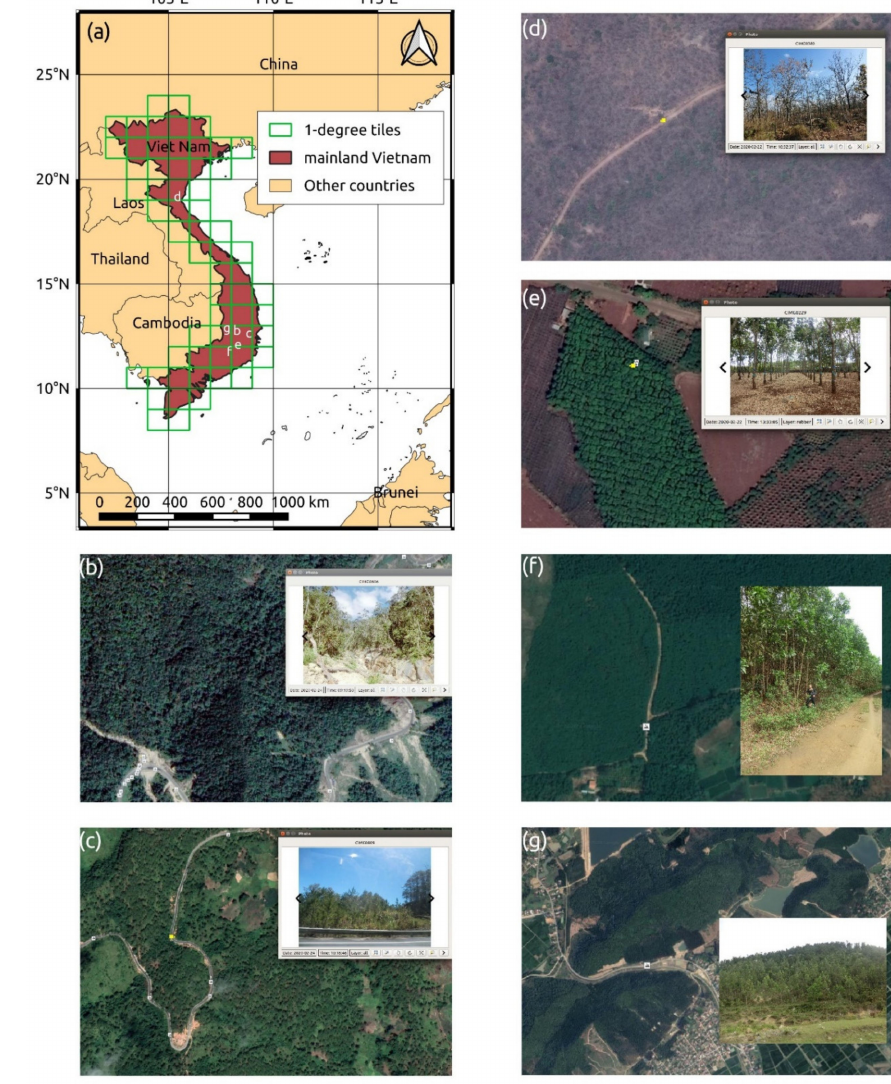
Figure 1. Study area and forest types in mainland Vietnam through ground-truth photos and high-resolution Google Earth (GE) images. ( a ) Location of mainland Vietnam; ( b ) natural evergreen broadleaf forest at 12.2209 ◦ N, 108.7455 ◦ E with a field photo (24 / 02 / 2020) and GE image (09 / 03 / 2019); ( c ) natural coniferous forest at 12.1338 ◦ N, 108.6196 ◦ E with a field photo (24 / 02 / 2020) and GE image (19 / 01 / 2020); ( d ) natural deciduous forest at 12.8436 ◦ N, 107.7780 ◦ E with a field photo (22 / 02 / 2020) and GE image (01 / 03 / 2020); ( e ) rubber plantation at 12.6557 ◦ N, 107.8437 ◦ E with a field photo (22 / 02 / 2020) and GE image (01 / 03 / 2019); ( f ) acacia plantation at 12.7768 ◦ N, 108.8242 ◦ E with a field photo (23 / 02 / 2020) and GE image (09 / 03 / 2020); ( g ) eucalyptus plantation at 19.1783 ◦ N, 105.5992 ◦ E with a field photo (23 / 03 / 2018) and GE image (09 / 03 /